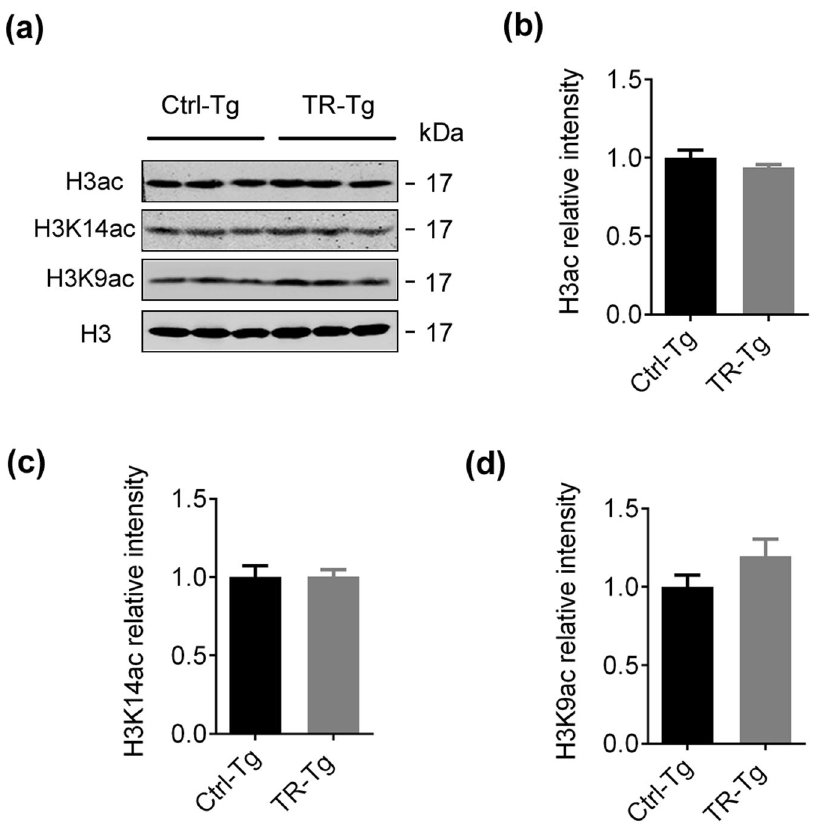
Figure 6. Paternal spatial training for 1 week does not induce transgenerational augmentation of histone acetylation in hippocampus in 3XTg offspring. ( a–d ) Acetylated H3 (H3ac), acetylated H3K14 (H3K14ac) and acetylated H3K9 (H3K9ac) level in hippocampus of 7-m 3XTg F1 offspring normalized by histone 3 (H3) measured by Western blotting. The blot images were cropped to display and quantitifed by the Odyssey Infrared Imaging System (Licor biosciences, Lincoln, NE, USA). Bar graphs show mean ± SEM. (two-tail t-test, n.s, n = 3 per